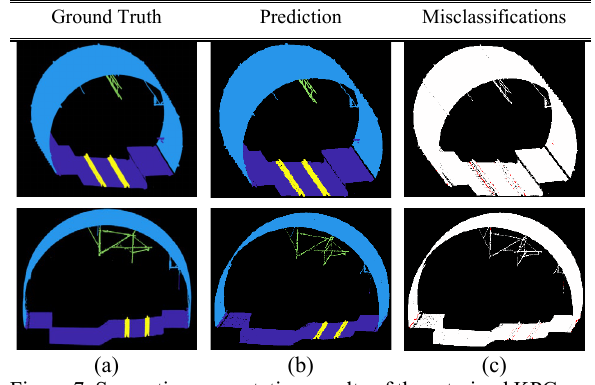
Figure 7. Semantic segmentation results of the retrained KPConv for tunnel A (top row) and B (bottom row). (a) Ground truth. (b) Prediction. (c) Misclassified points (in red).